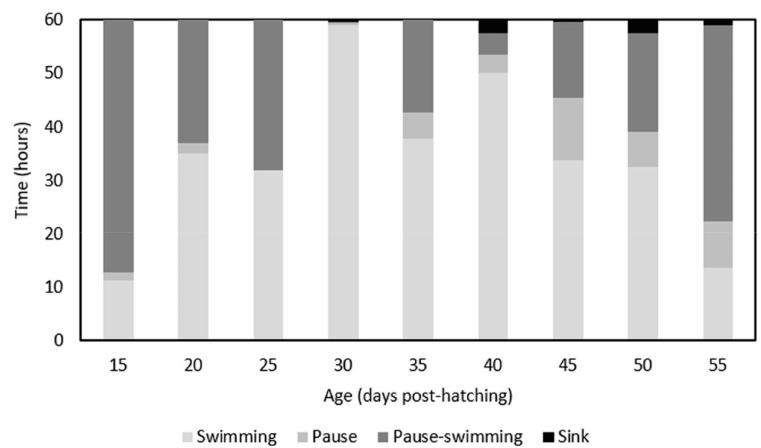
Figure 6. Mean time that white seabream Diplodus sargus (Linnaeus, 1758) larvae spent doing each Modal Action Pattern behavior (swimming, pause-swimming, pause, and sink) along ontogeny (DPH—days